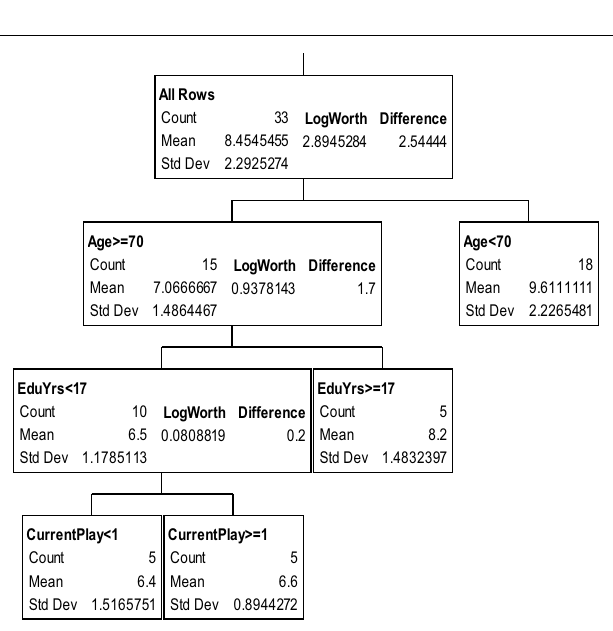
FIGURE 4 | Partition analysis for grooved pegboard non-dominant hand scaled